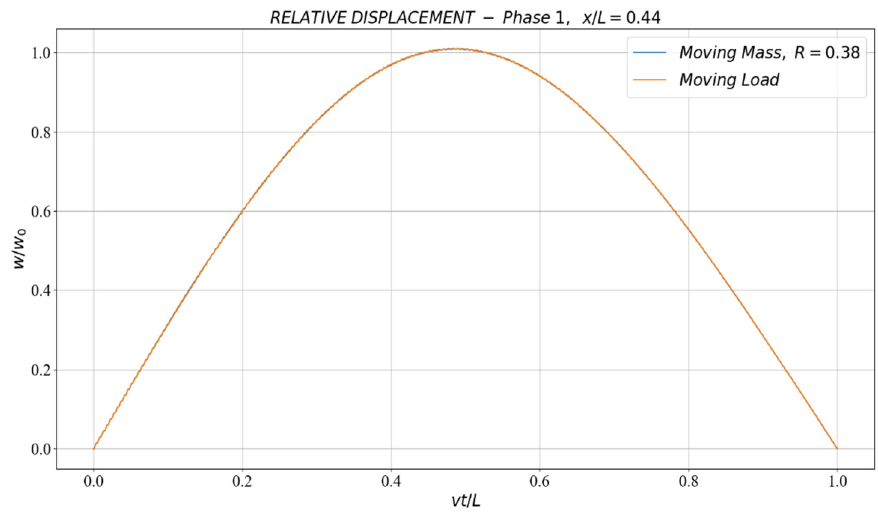
Figure 5. Forced vibration time history of the deck displacement at station x = 7L/16 of the bridge for a light m = 38.60 kg mass traversing at a low speed of v = 0.247 m/s.